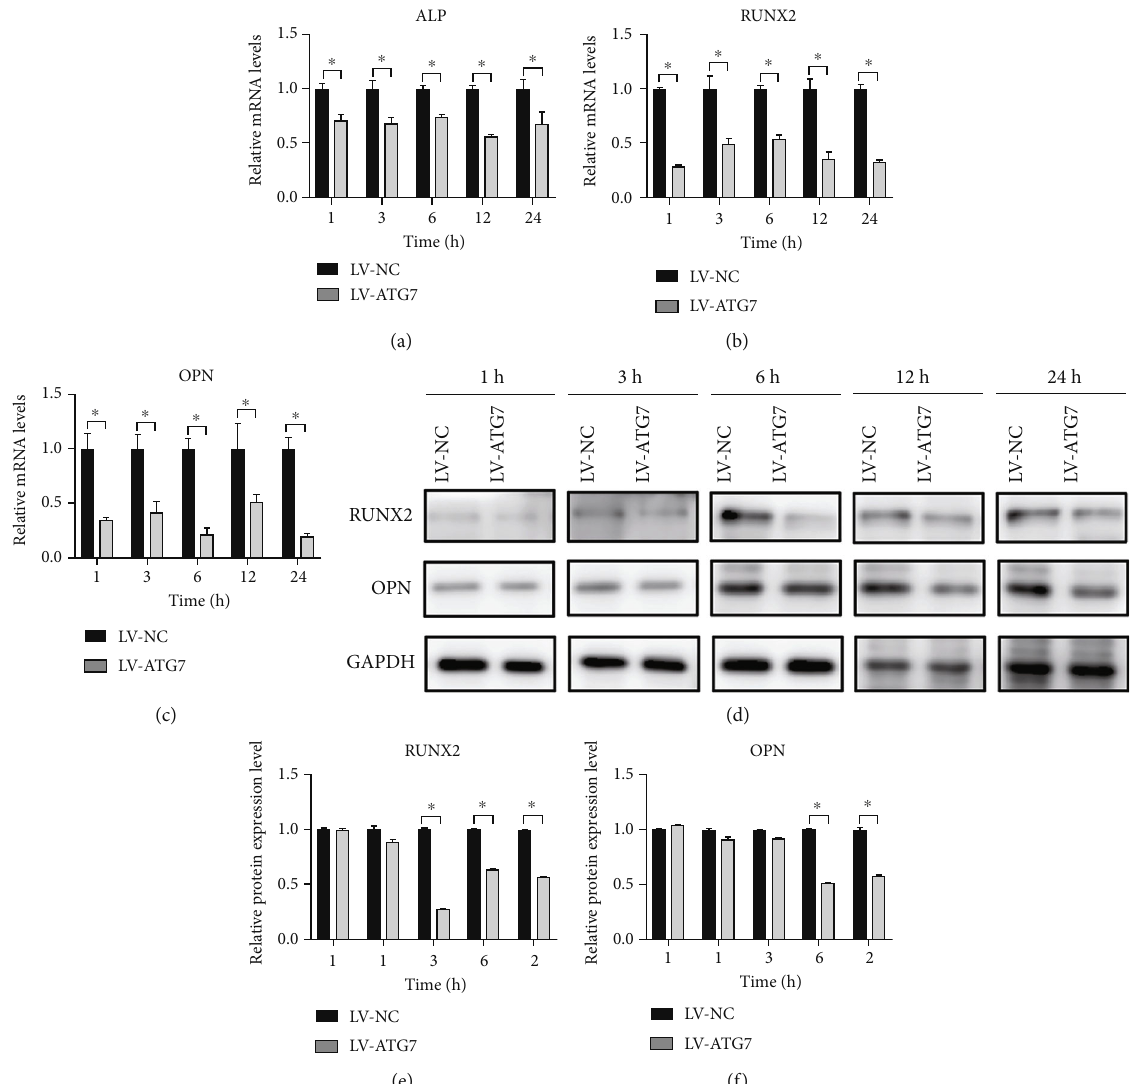
Figure 8: Changes in osteogenic levels after knocking down the autophagy-related gene ATG7. (a – c) ALP-, RUNX2-, and OPN-relative mRNA expression levels assessed by real-time PCR in both the LV-NC and LV-ATG7 groups. (d – f) RUNX2- and OPN-relative protein expression levels assessed by western blotting in both the LV-NC and LV-ATG7 groups. ∗ P < 0 : 05 . PCR: polymerase chain